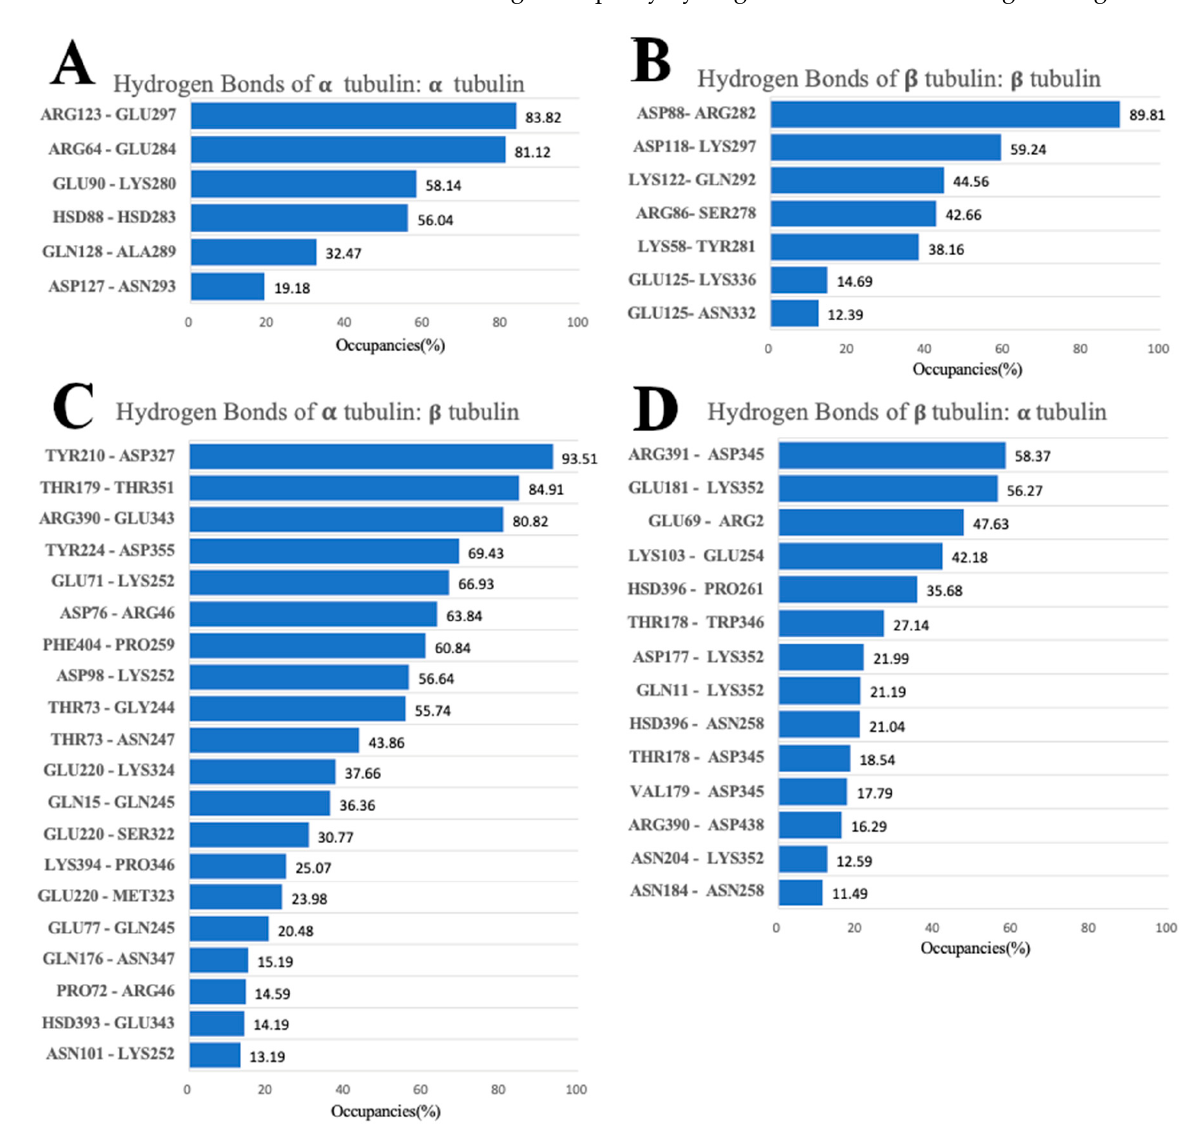
Figure 7. Hydrogen bonds at the interfaces of α / α , β / β , α / β , and β / α tubulin complexes with their occupancies. ( A ) α / α tubulin complex. ( B ) β / β tubulin complex. ( C ) α / β tubulin complex. ( D ) β / α tubulin